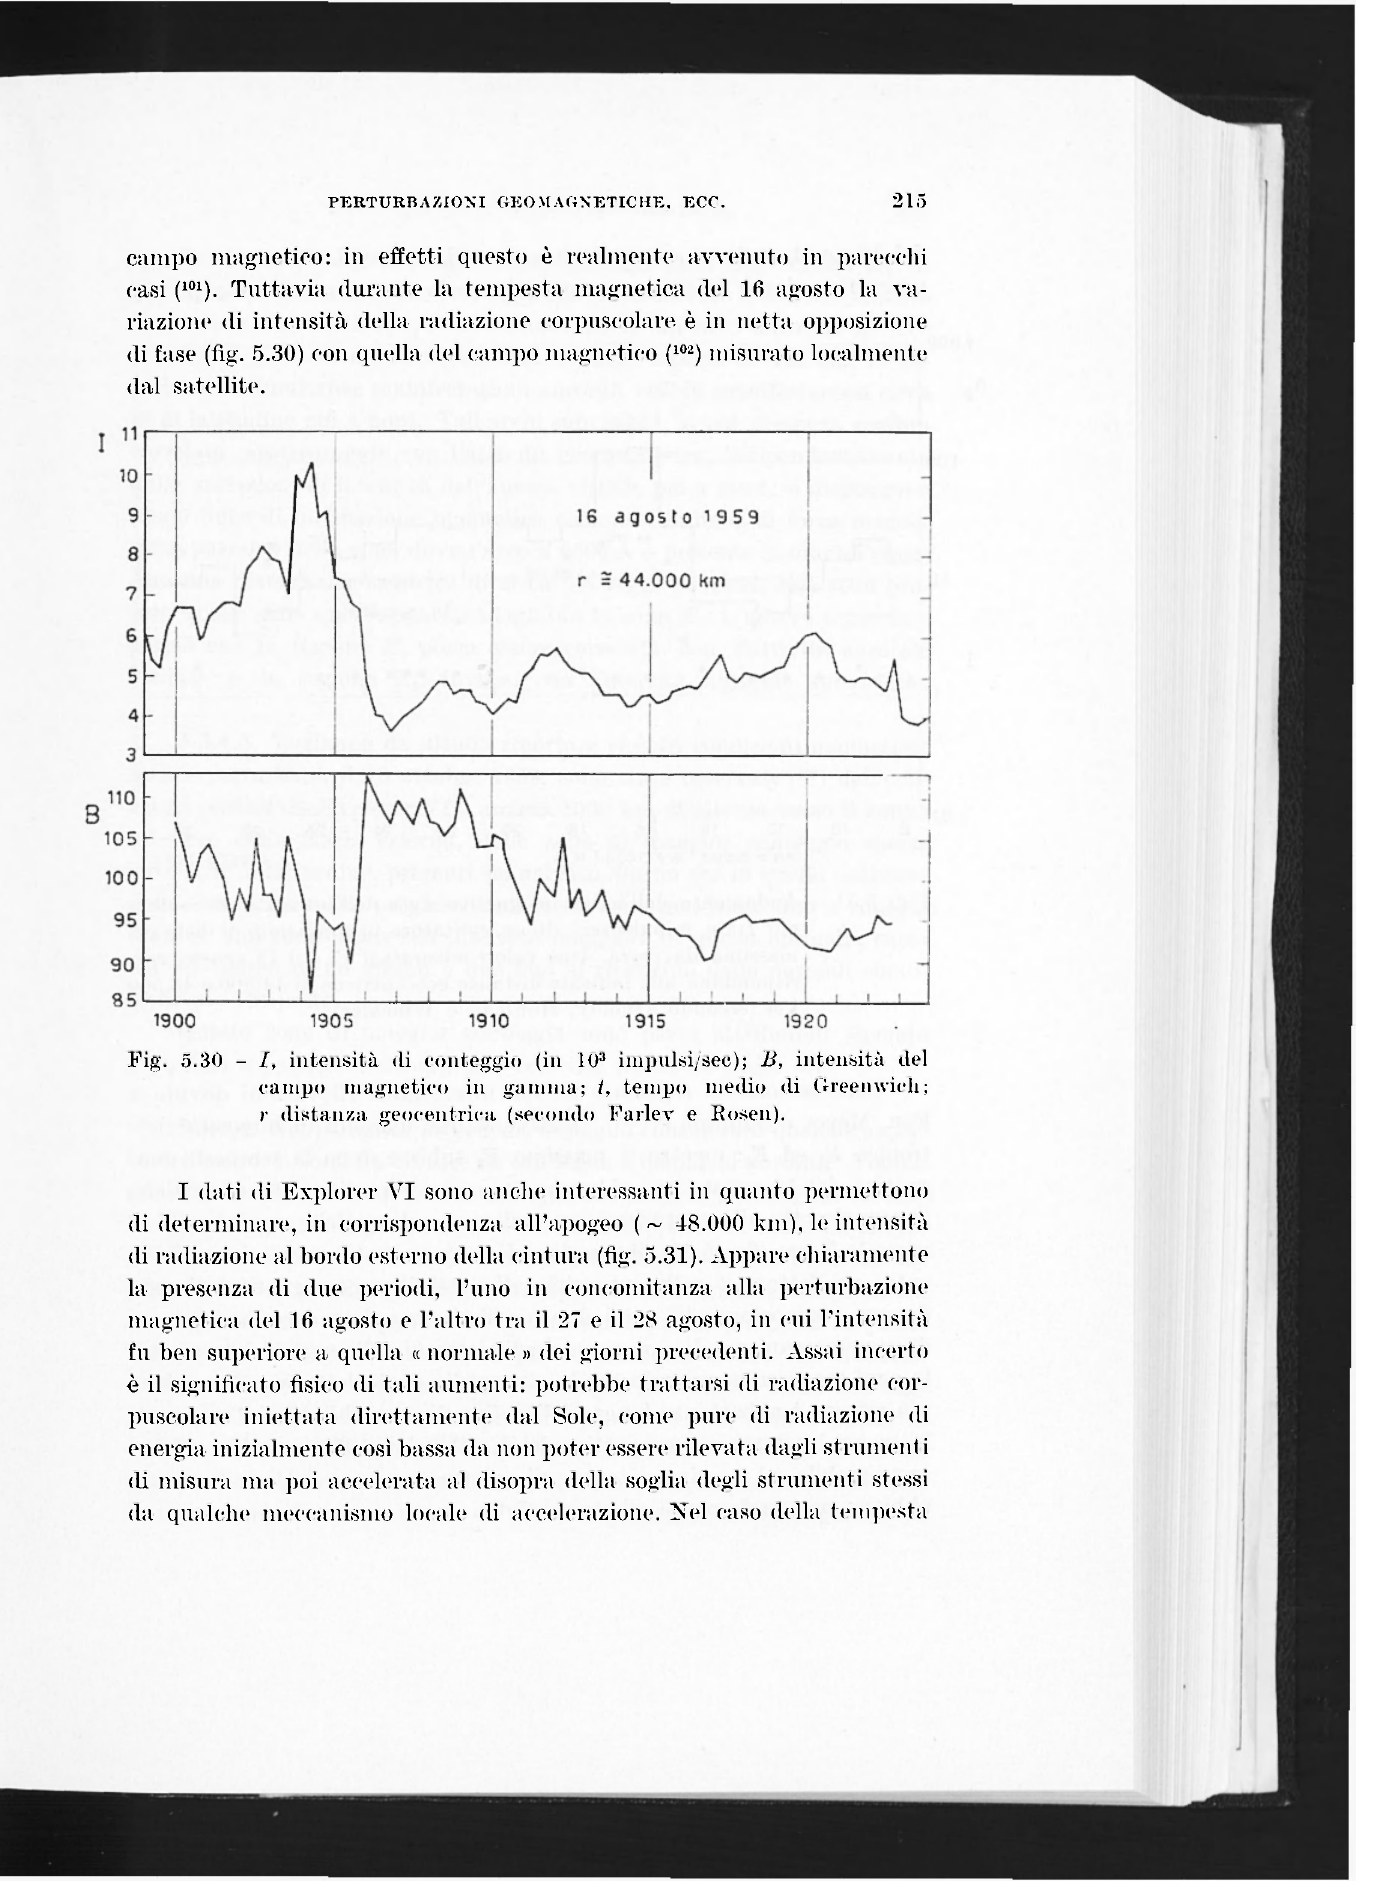
Fig. 5.30 - /, intensità (li conteggio (in IO 3 impulsi/sec); B, intensità del campo magnetico in gamma; t, tempo medio di Greemvicli; r distanza geocentrica (secondo Farlev e